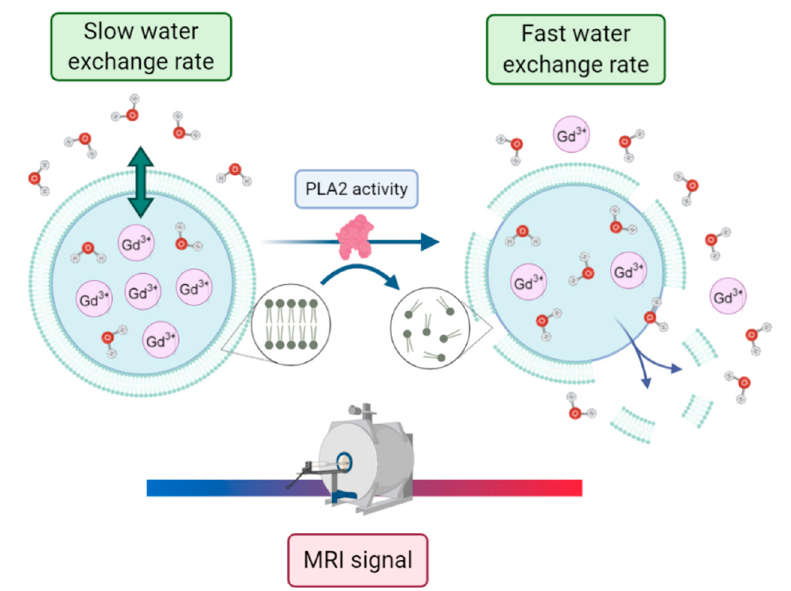
Figure 12. The enzyme phospholipase A2 (PLA2) catalyzes the lipidic bilayer hydrolysis of liposomes loaded with high concentrations of paramagnetic species. The water exchange rate across the liposomal membrane is increased, leading to a detectable increase in the bulk water magnetic resonance imaging (MRI) signal that is proportional to PLA2 activity. Figure inspired by [66].